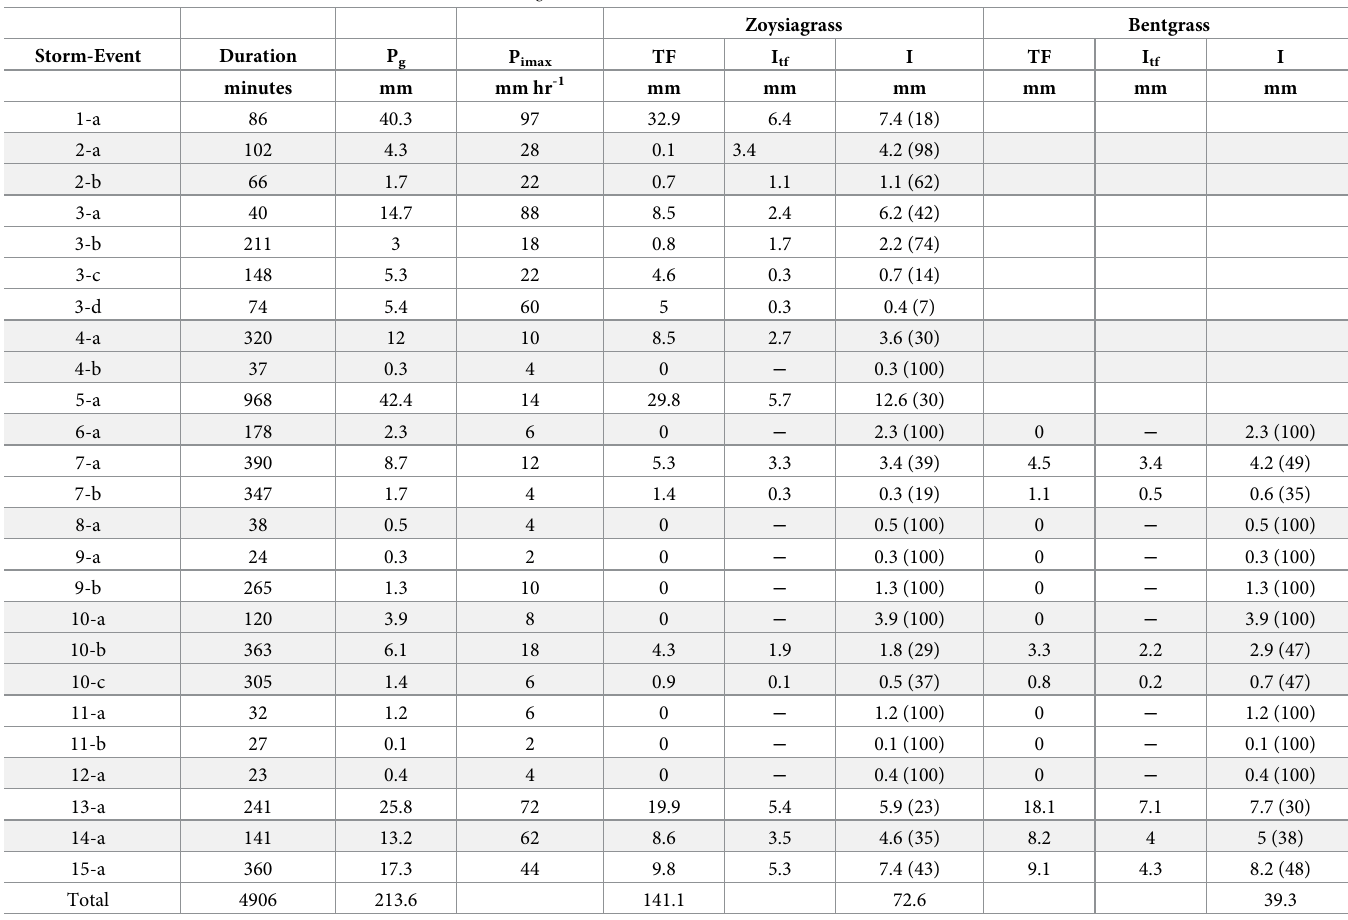
Table 1. Table showing the duration, gross precipitation ( P g ), precipitation maximum intensity ( P imax ), throughfall ( TF ), interception until the point of throughfall ( I tf ), and canopy interception ( I ) for each individual precipitation event across 15 storms for turfgrass patches of ‘Meyer’ zoysiagrass and creeping bentgrass. Can- opy interception values in parenthesis represent the percentage of P . Values for each precipitation event are the average of three g